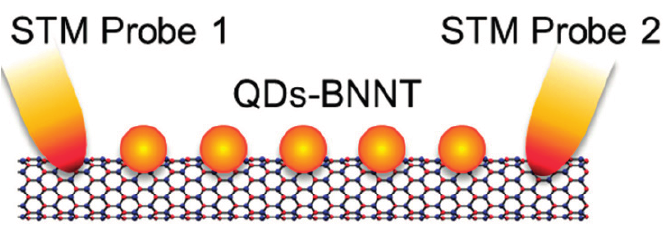
Figure 4. A Schematic diagram of a gold nanoparticle-decorated BNNT based room temperature tunneling field effect transistor. Reprinted with permission from [107]; © 2013 WILEY-VCH Verlag GmbH & Co.